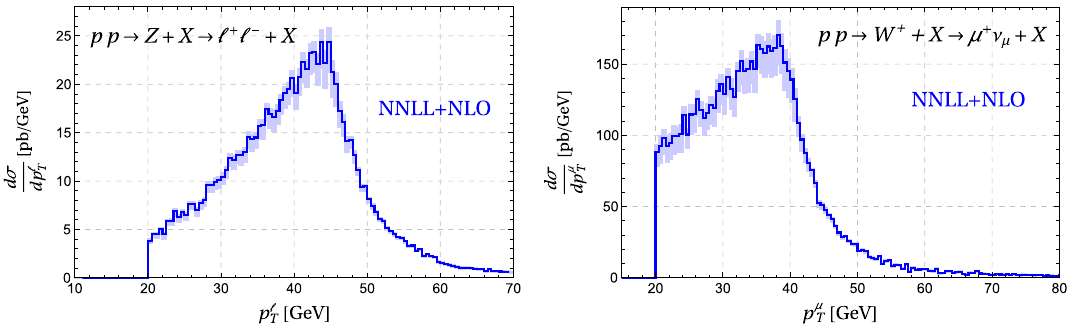
> 20GeV and | η (cid:4) | < 2 . 4. Left: Lepton transverse momentum in Z boson √ T s = 7TeV. The bands show the scale uncertainties